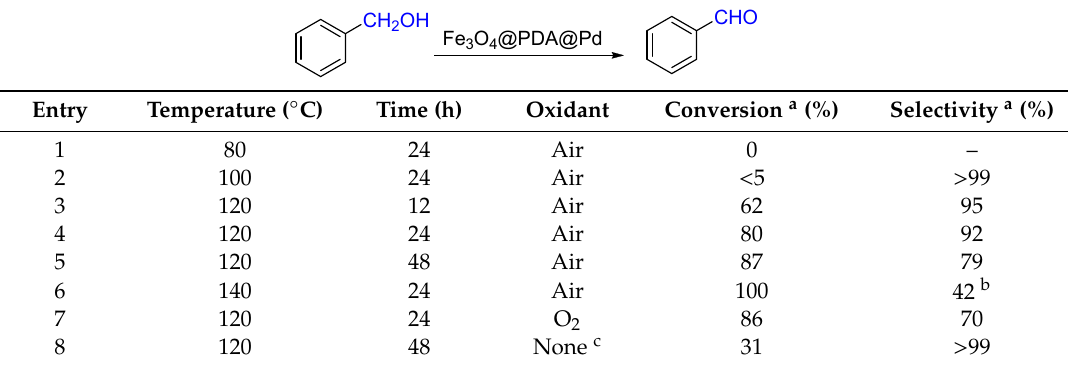
Table 2. Optimization of reaction conditions.